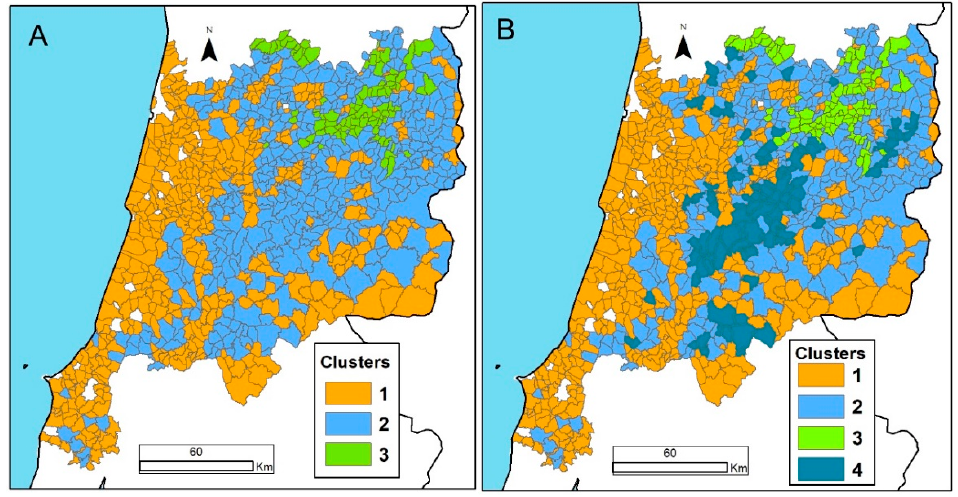
Figure 4. Spatial distributions of the cluster solutions. ( A ) Three clusters, numbered 1 to 3; ( B ) four clusters, numbered 1 to 4.